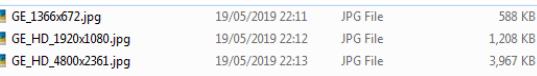
Figure 9c. Maximum resolution (4800 x 2361)